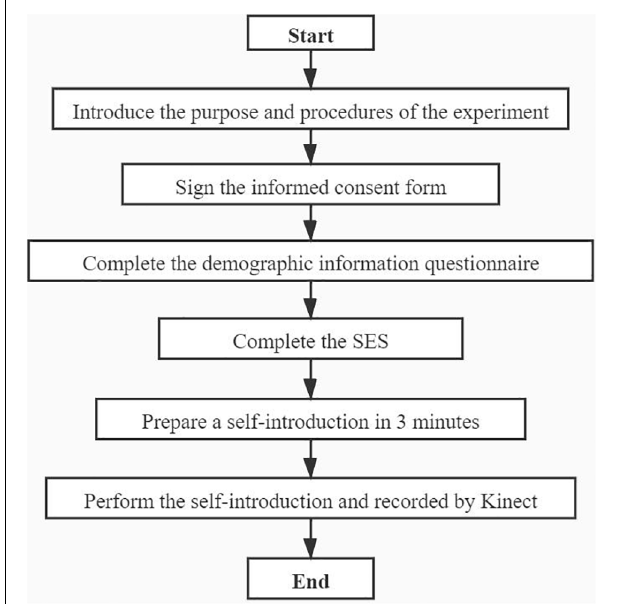
FIGURE 3 | The whole process of the